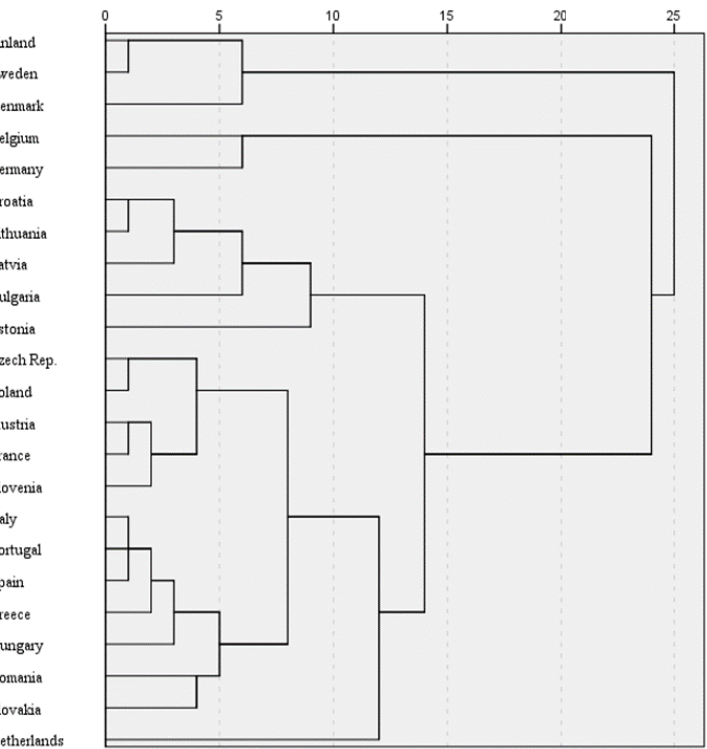
Figure 5. Dendrogram reflecting clusters of sustainability models. Source: authors’ projection.